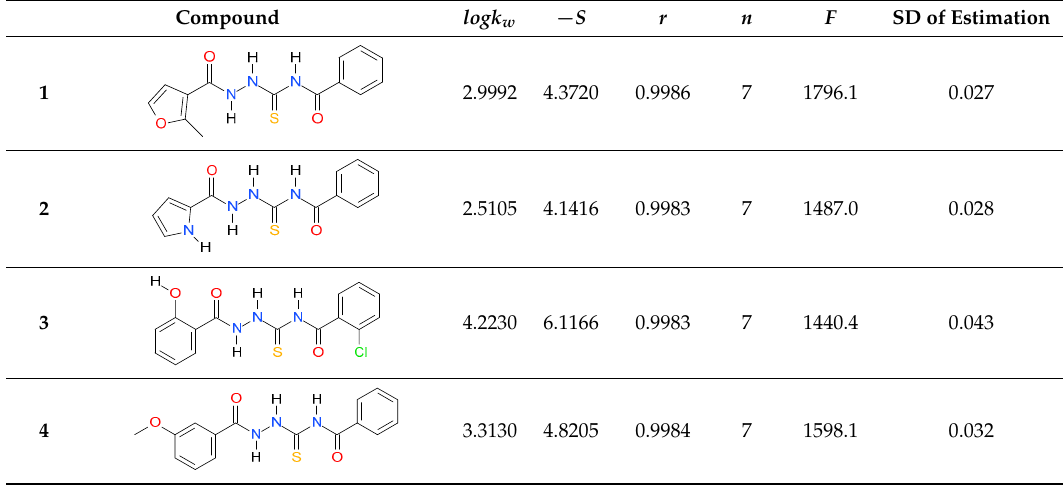
Table 1. Parameters of Equation (1). Obtained F values were higher than F -critical in each case. Compound logk w SD of Compound